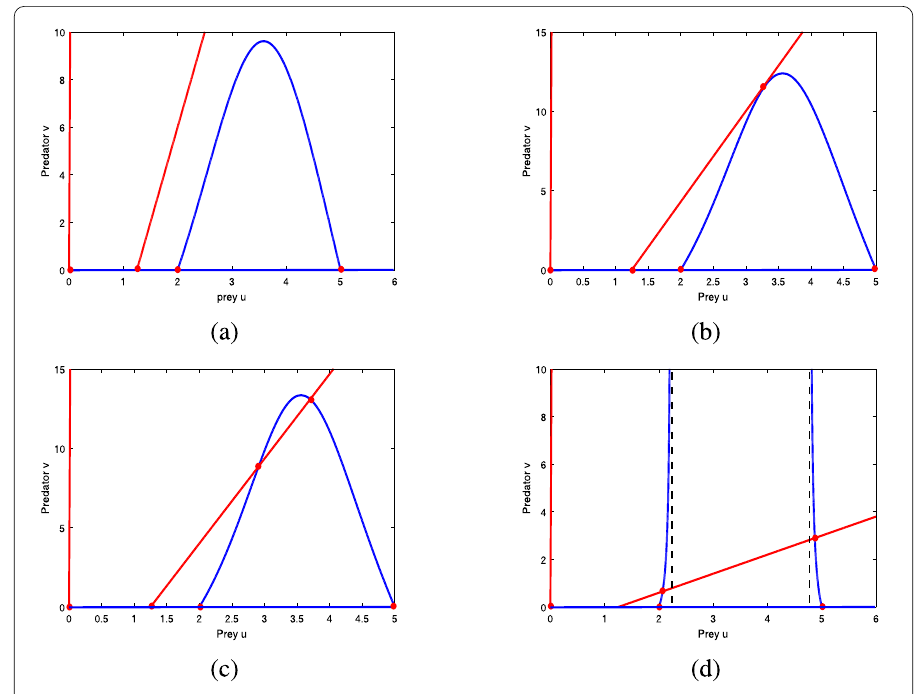
Figure 1 The blue curves are the prey-nullclines and the red lines are the predator-isoclines. The four figures are the possible plots of predator-nullcline for four different values of c . (a) For c = 0.2, two nullclines do not intersect at any point in the interior of the feasible domain (the prey nullcline is below the predator nullcline), suggesting there is no equilibrium point; (b) as we increase the slope of predator-nullcline, the two equilibria approach each other and collide for c = 0.28 and consequently, there is one equilibrium point; (c) for c = 0.3, both the nullclines cross twice, suggesting there are two equilibrium points; (d) for c = 2, the prey nullcline is unbounded and has two vertical asymptotes x = x ± shown by black lines. The other parameter values are r = 0.8, K = 5, q = 0.2, a = 2, b = 0.4, d = 0.1, e = 0.2, m =